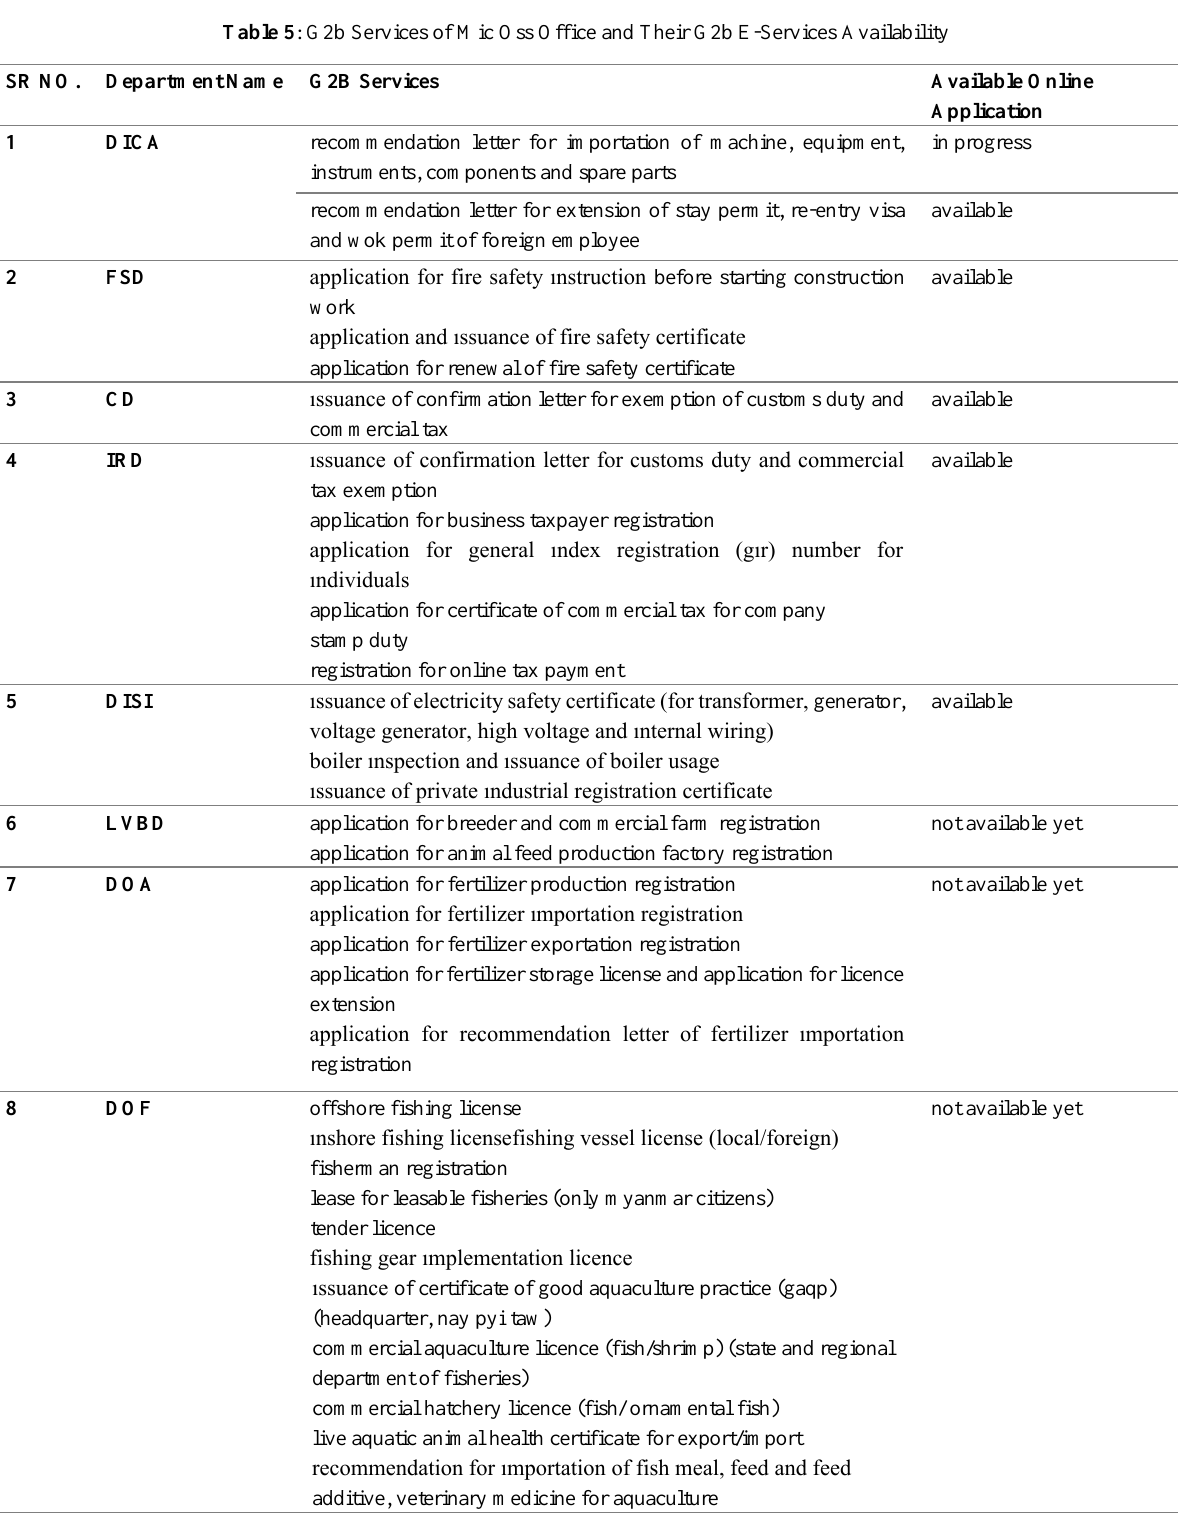
Table 5 : G2b Services of Mic Oss Office and Their G2b E-Services Availability SR